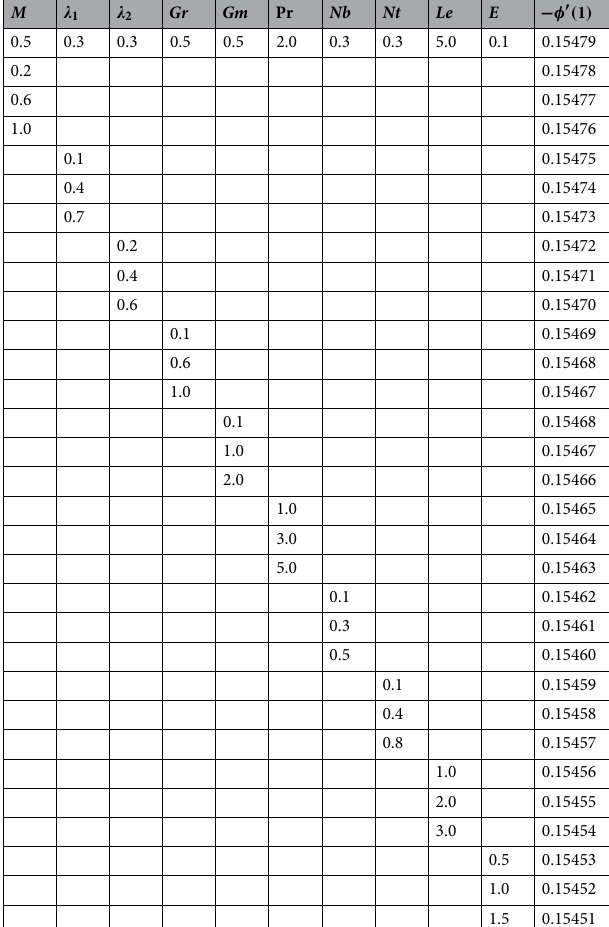
Table 4. Variation in Sherwood number